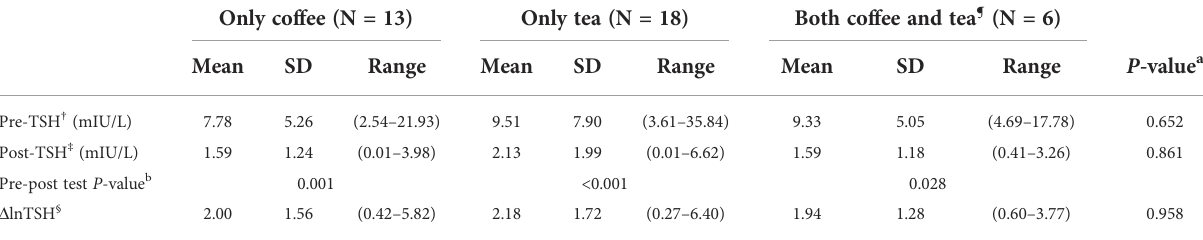
TABLE 2 Comparison of the pre- and post-TSH concentrations and D lnTSH of the patients in the only tea, only coffee, and both coffee and tea